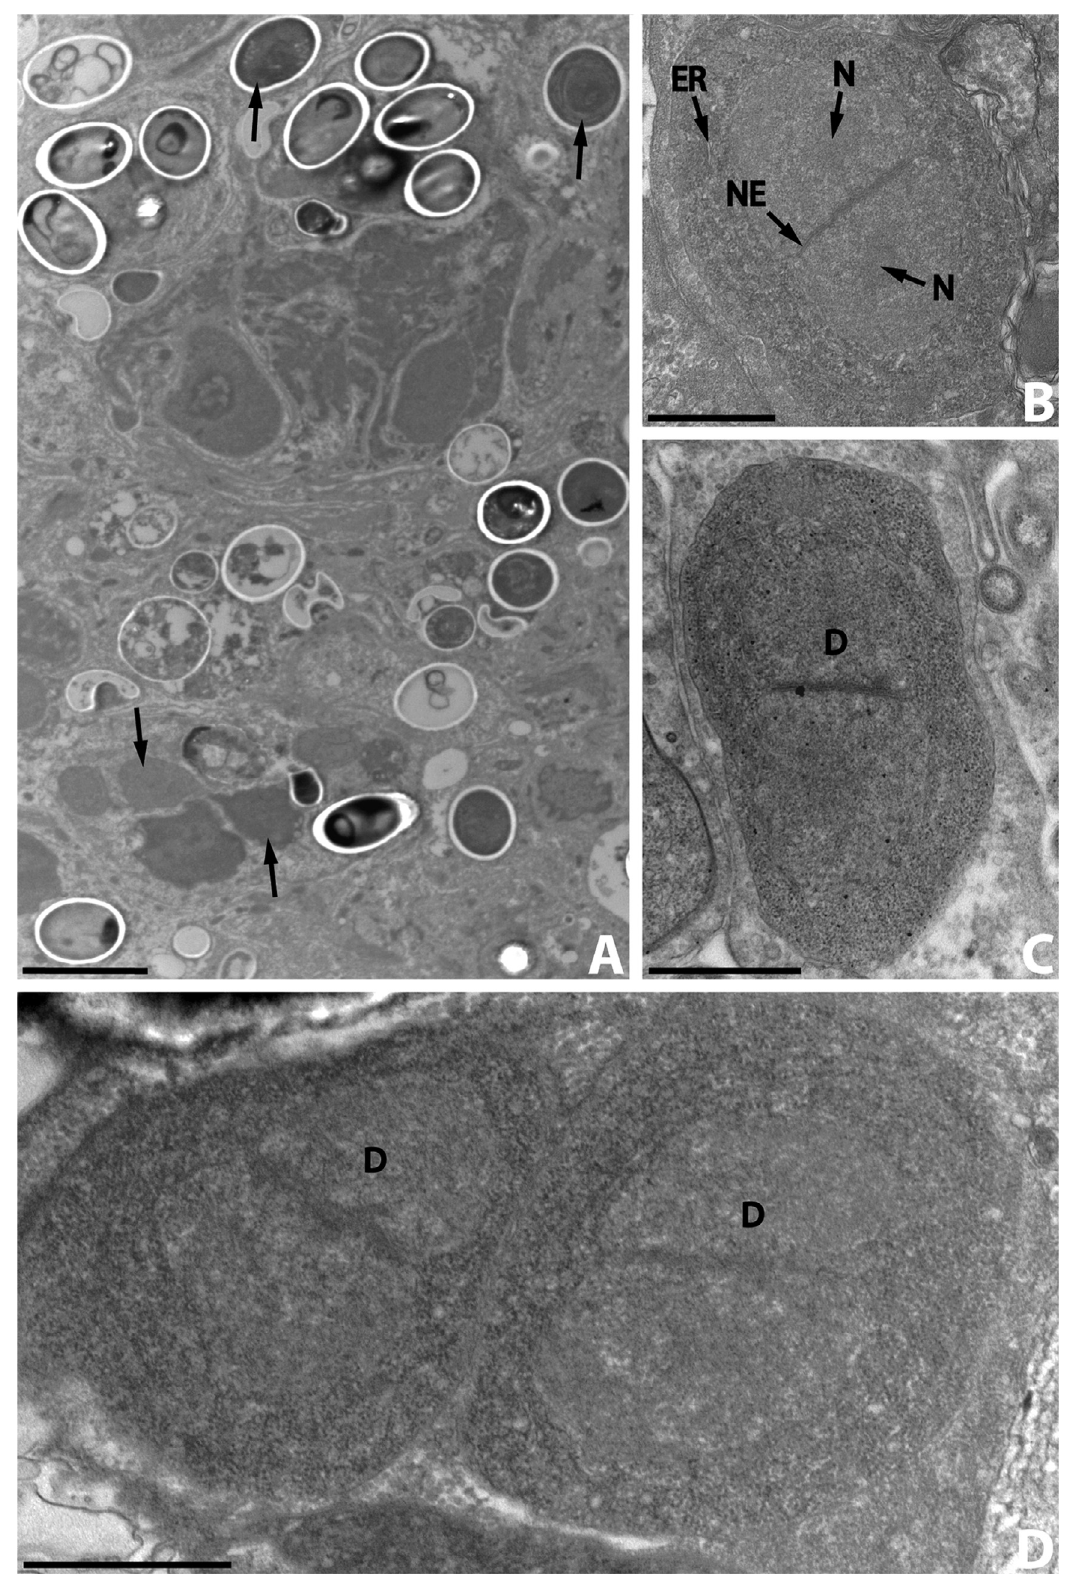
Figure 1. A. Ultrastructural aspects of the different developmental stages (arrows) of Nosema podocotyloidis n. sp. from Podocotyloides magnatestis . B. Ovoid meront. C. Elongate meront. D. Binary fission of meront with two diplokarya. D: diplokaryon; ER: endoplasmic reticulum; N: nucleolus; NE: nuclear envelope. Scale Bars: A, 5 l m; B, C and D, 1 l